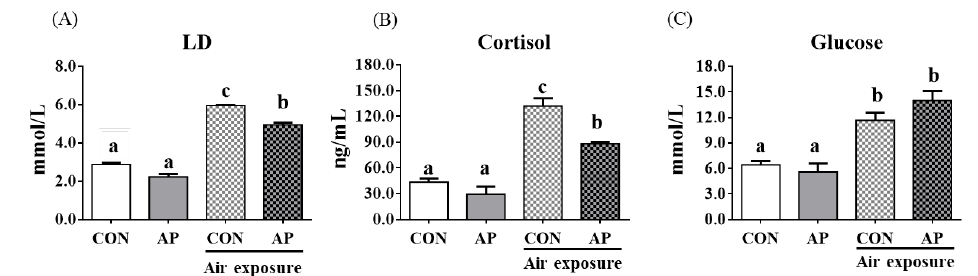
Figure 1. Plasma stress biomarkers in the two groups before and after air exposure stress. LD ( A ), cortisol ( B ), and glucose ( C ). Values are represented as the mean ± SEM ( n = 6). Bars with different lowercase letters mean significant differences among groups ( p < 0.05).